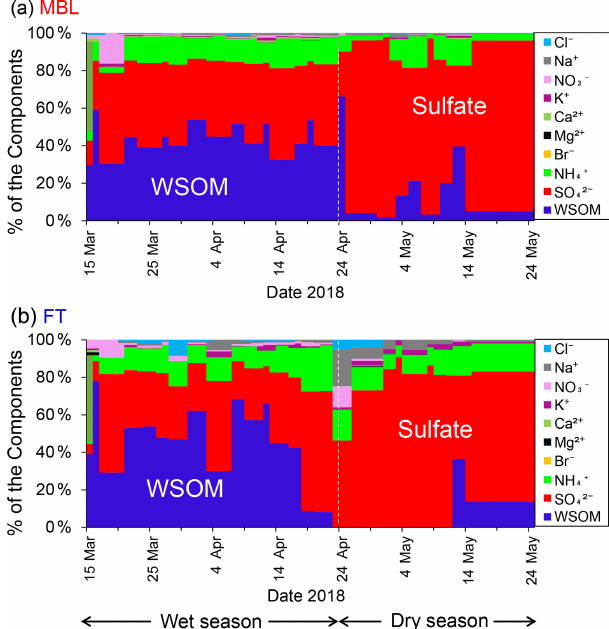
Figure 3. Time series of the chemical mass fraction of the sub- micrometer water-soluble aerosols under (a) MBL (in daytime) and (b) FT (in nighttime) conditions throughout the sampling pe-